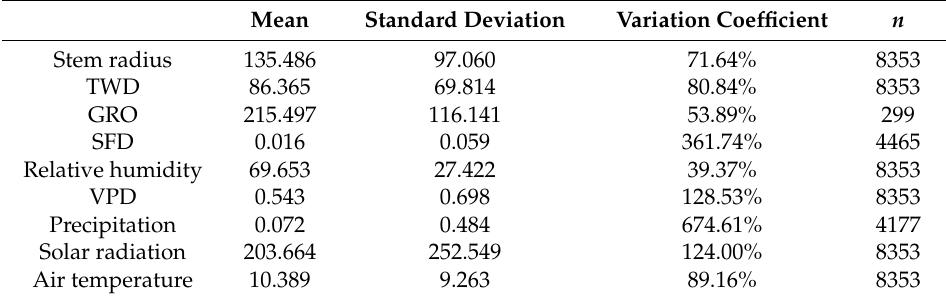
Table 2. The mean, standard deviations and variation coefficients of stem radius variations and hydro-thermal factors during the period of the cambium activation (11 April to 1